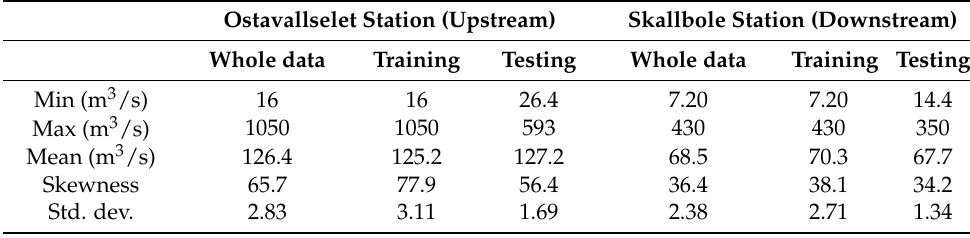
Figure 1. Location map of selected stations. Table 1. The statistical parameters of the streamflow